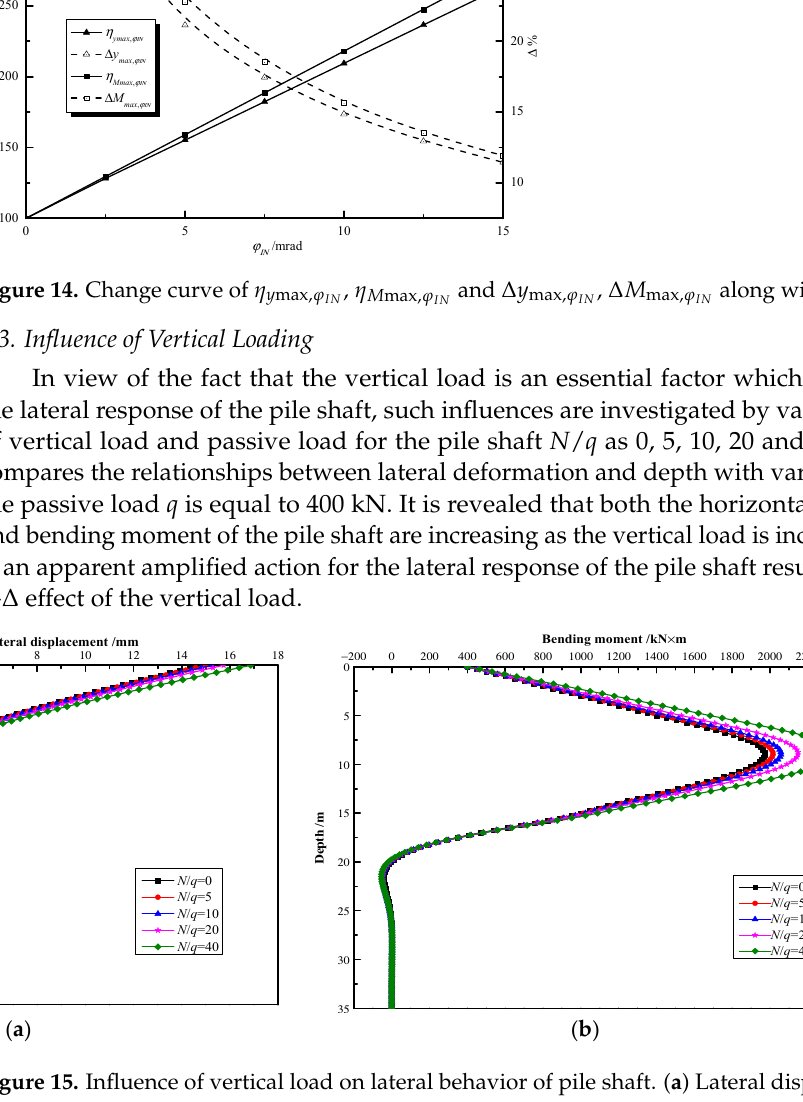
Figure 14. Change curve of η y max, ϕ along with